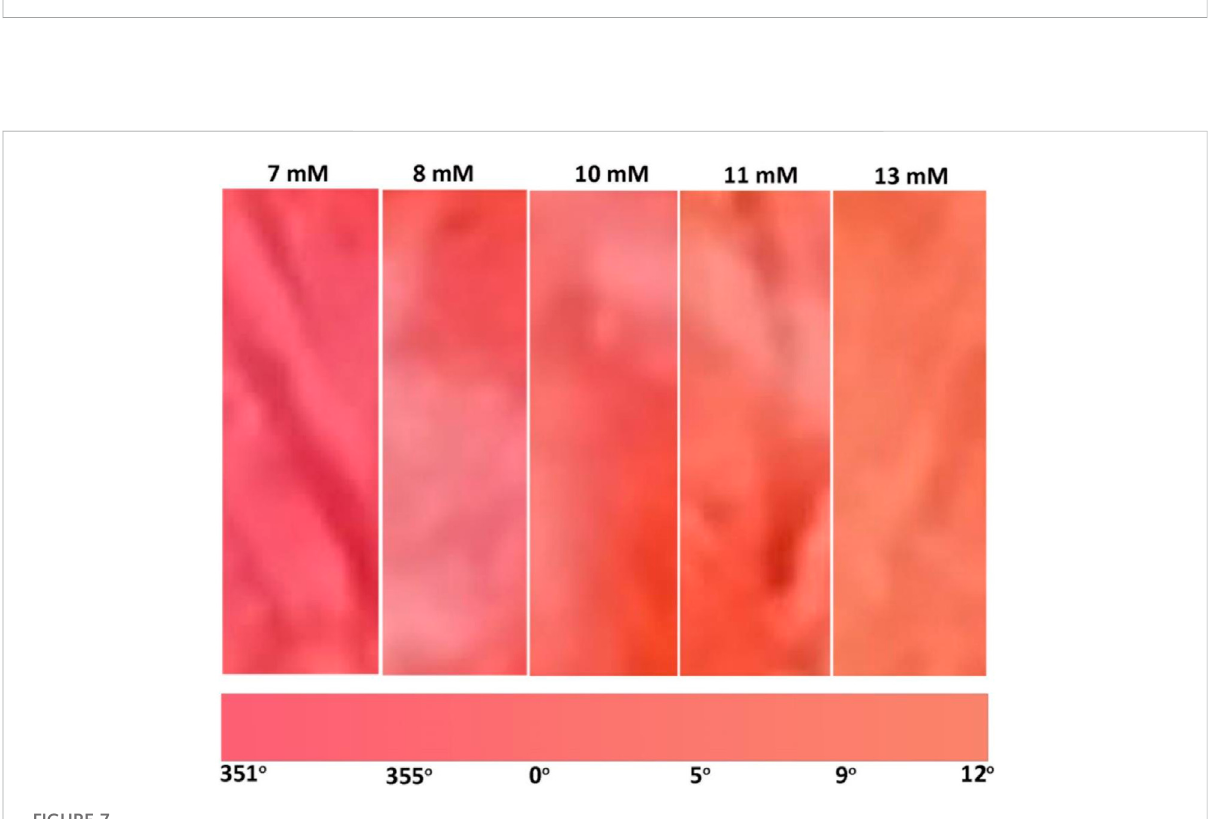
FIGURE 7 Gradient of color change produced by glucose concentration of medical interest ranging from 7 to 13